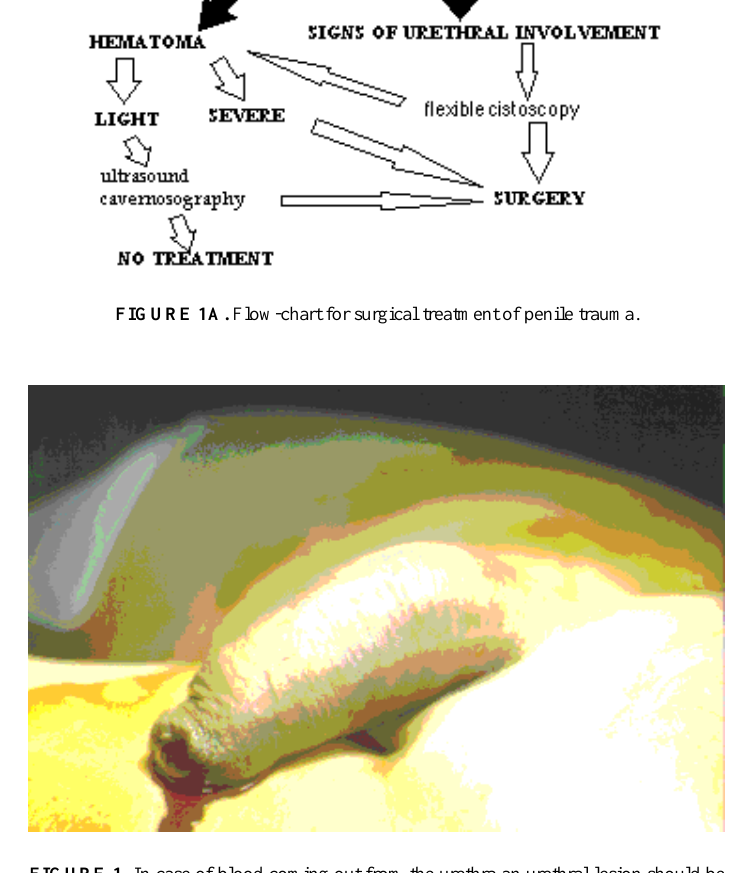
FIGURE 1 . In case of blood coming out from the urethra an urethral lesion should be always suspected even in case of limited hematoma and slight penile swelling.